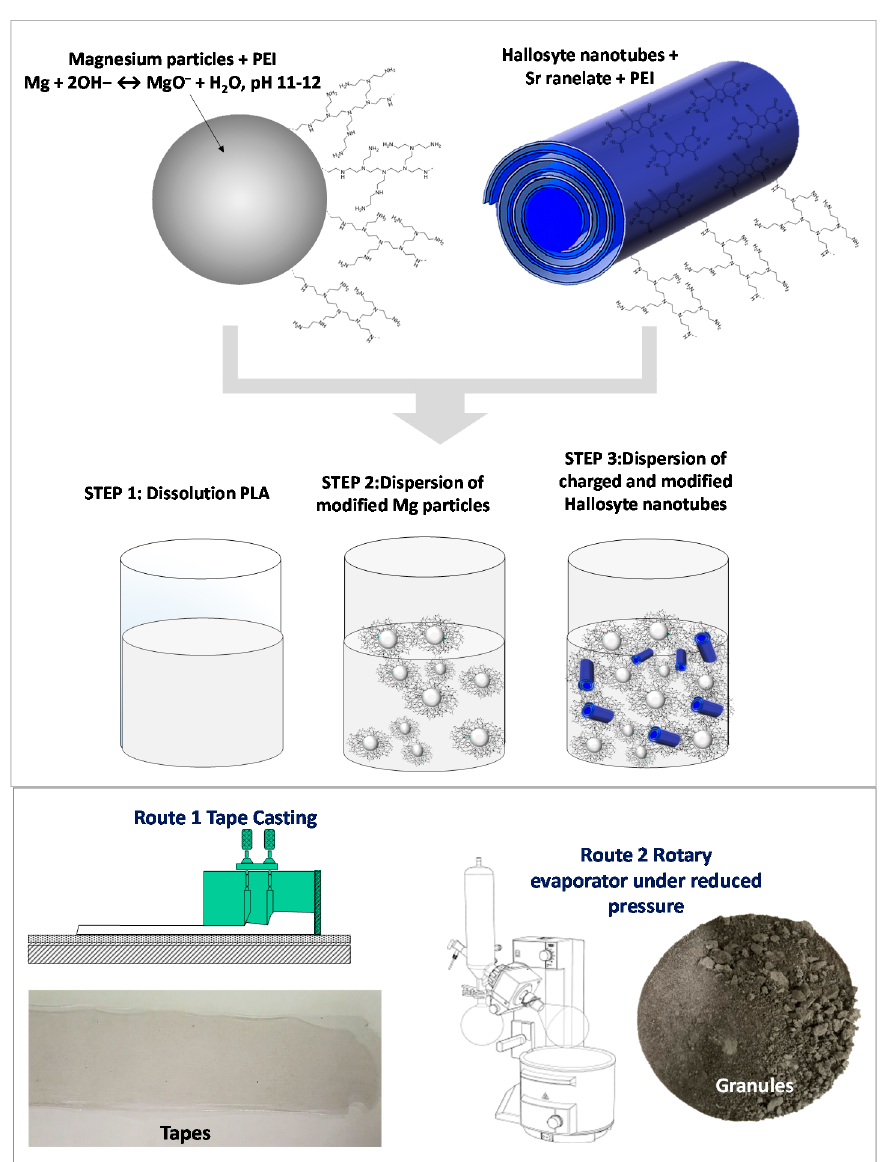
Figure 1. Scheme of the fabrication procedure of films and granules. Table 1. Summary of the formulated composites.